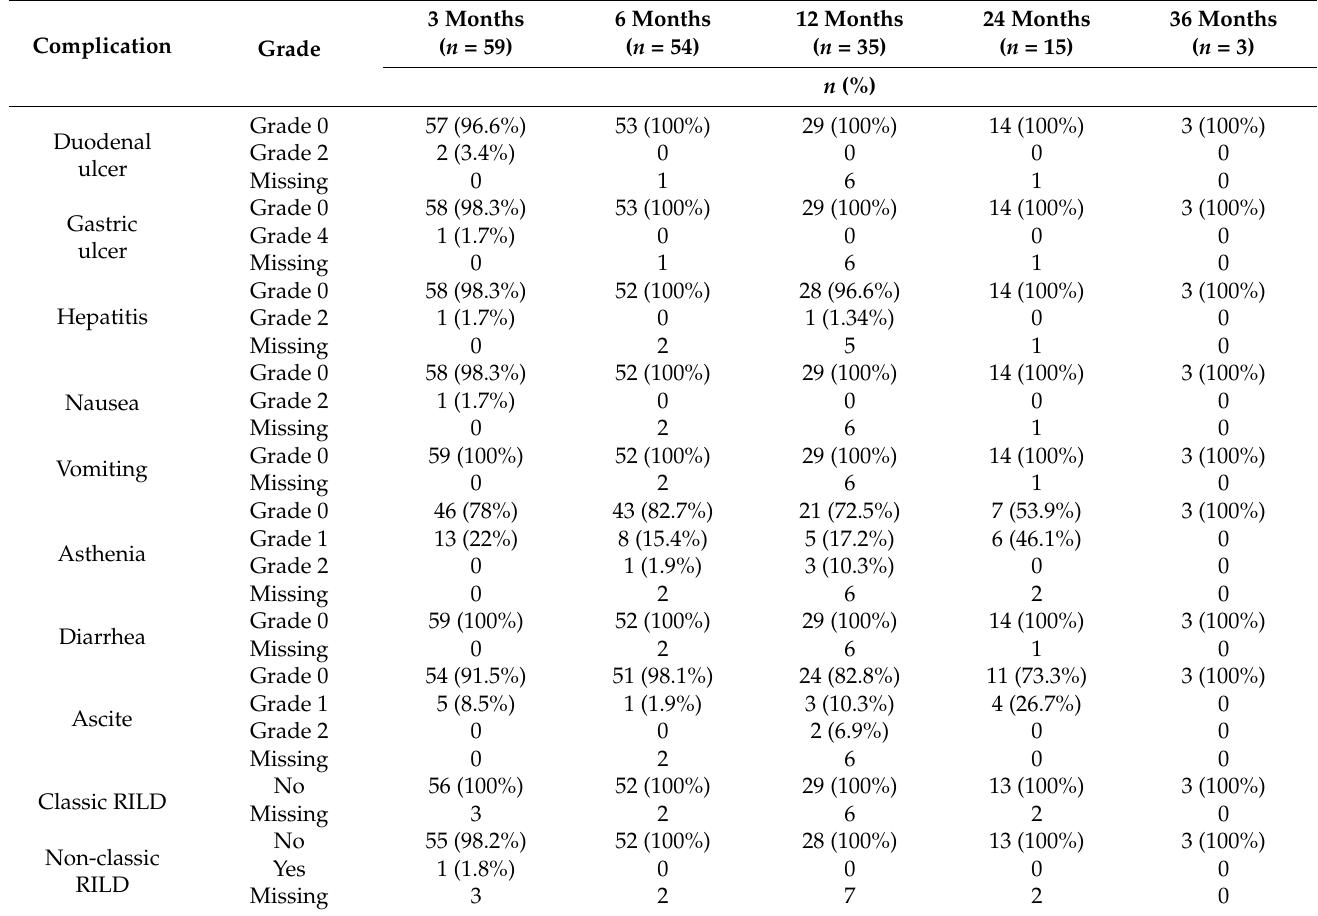
Table 6. Tolerance of